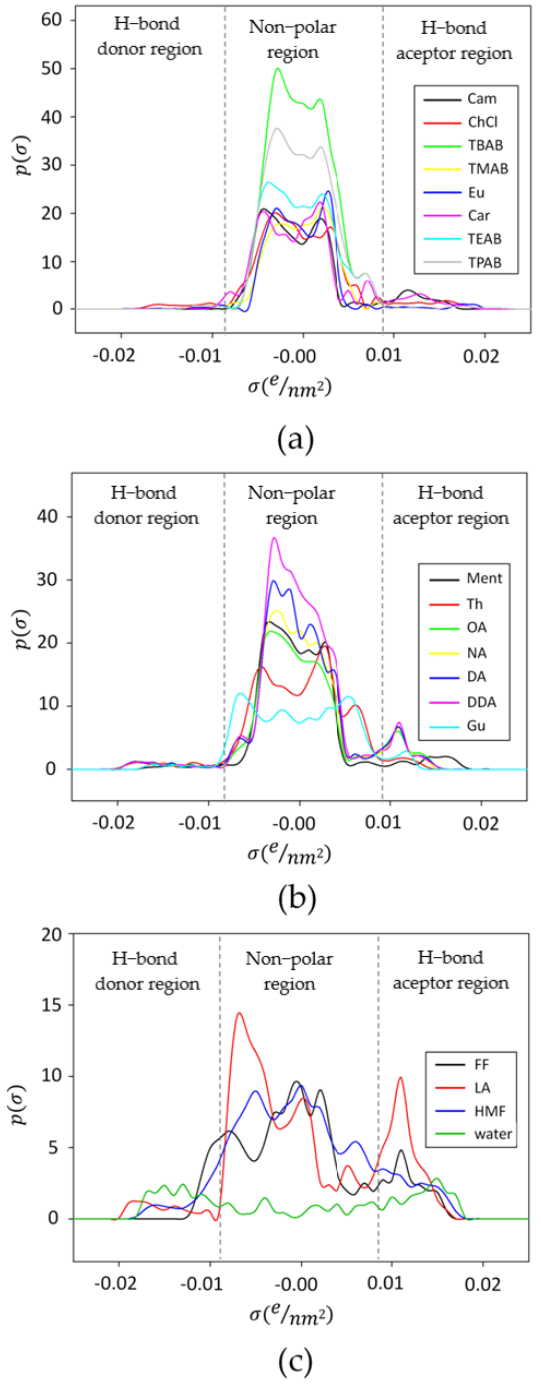
Figure 4. σ -profiles of chemical compounds used as ( a ) hydrogen bond acceptors; ( b ) hydrogen bond donors; ( c ) extracted compounds (FF, HMF, LA), and water. Dashed lines indicate the value ranges for the hydrogen-bond interaction ( σ = ± 0.0084 e/Å 2